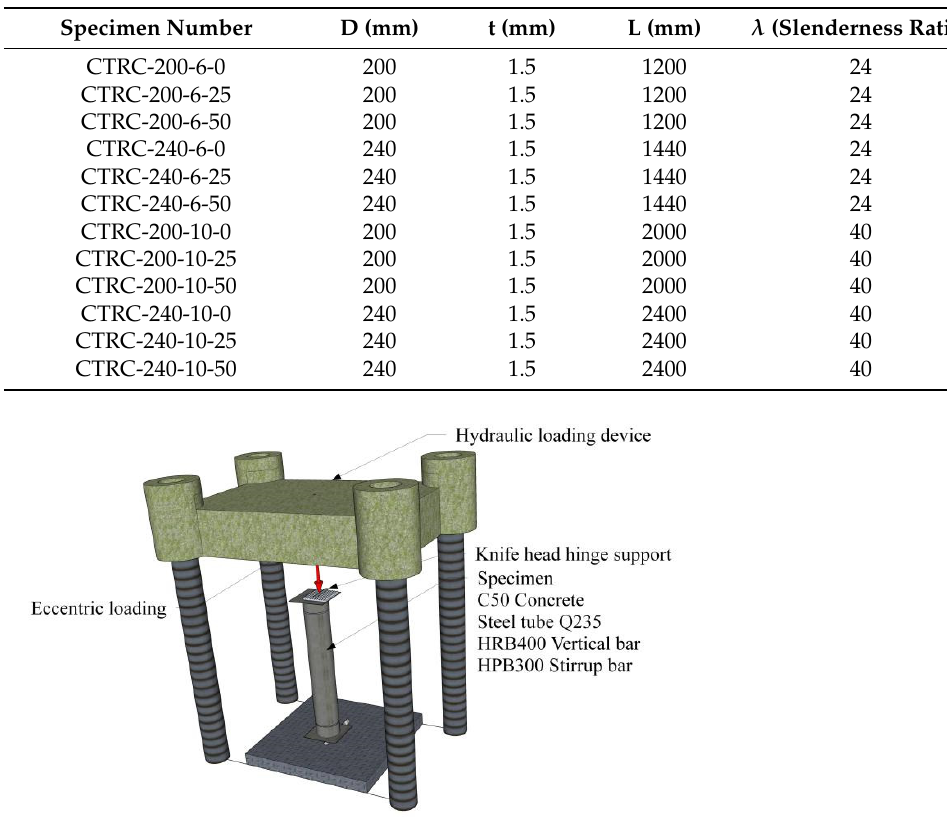
Figure 2. Test device diagram.